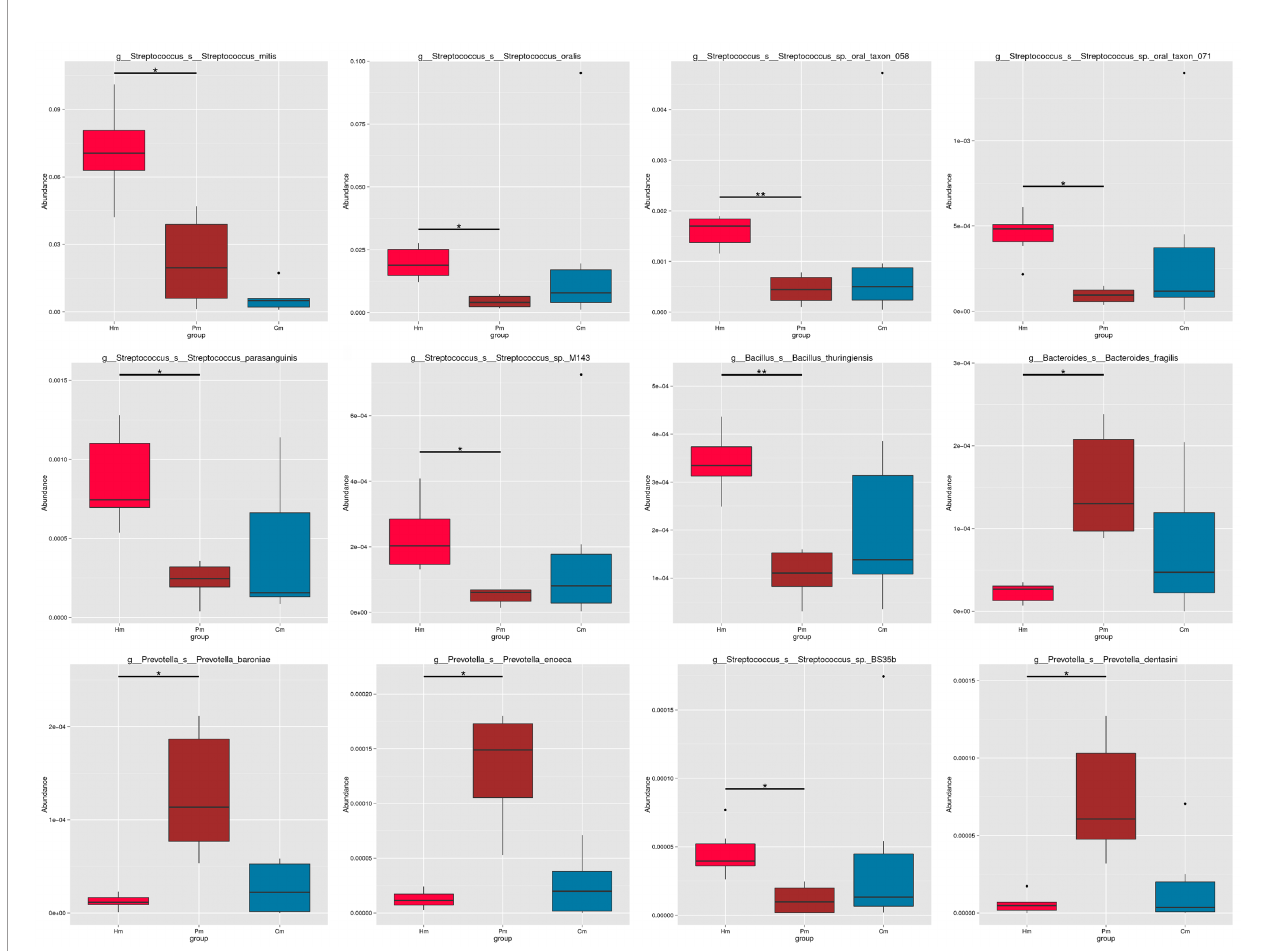
FIGURE 3 | Differences in the abundance of 12 genera among the Hm, Pm, and Cm groups. Metastats was used to test the differences in the microbial composition between groups, with q -values computed for the multiple comparisons. * q -value < 0.05; ** q -value < 0.01. Hm, healthy individuals; Pm, patients with periodontitis alone; Cm, patients with Crohn ’ s disease and